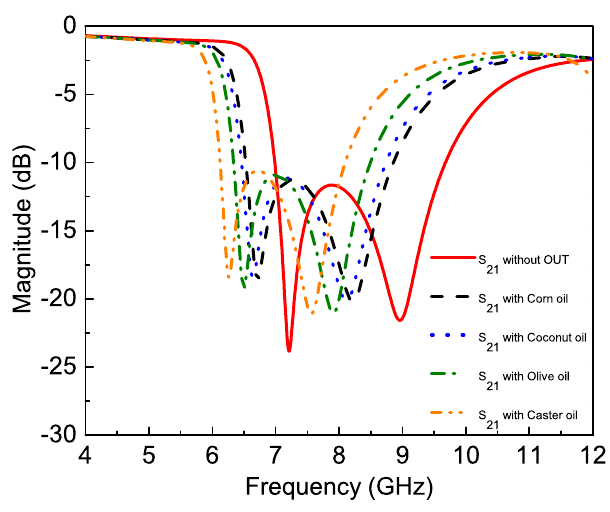
Figure 8. The magnitude of transmission ( S 21 ) coefficients for the complementary metaresonator sensor due to interaction with different OUT.